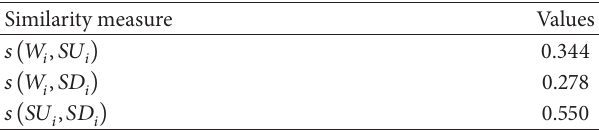
Table 1: Similarity measure comparison between patterns.